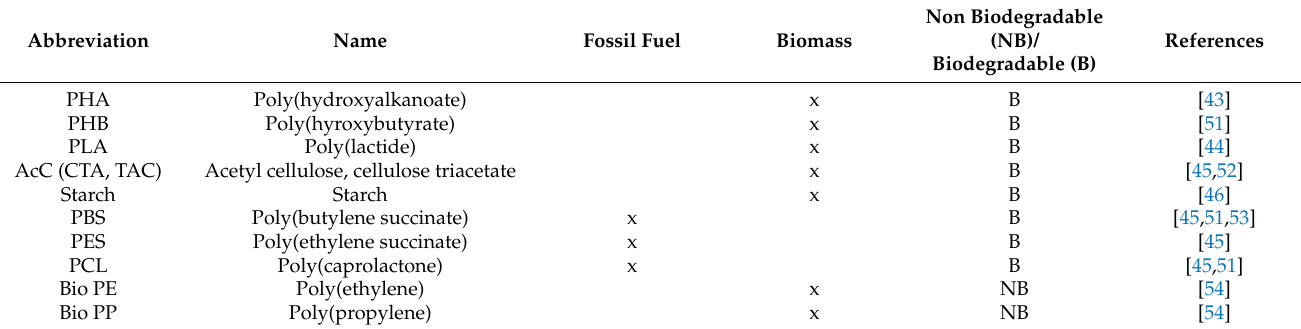
Table 1. Source and biodegradability of commonly used